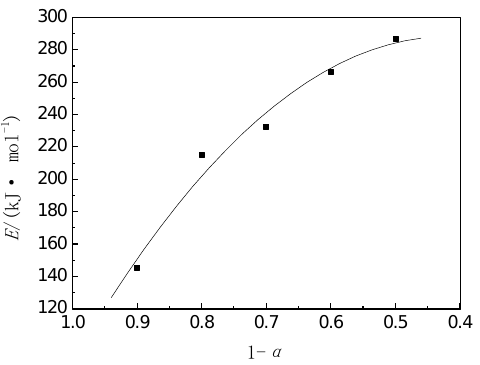
values for BIIR decomposition in air.